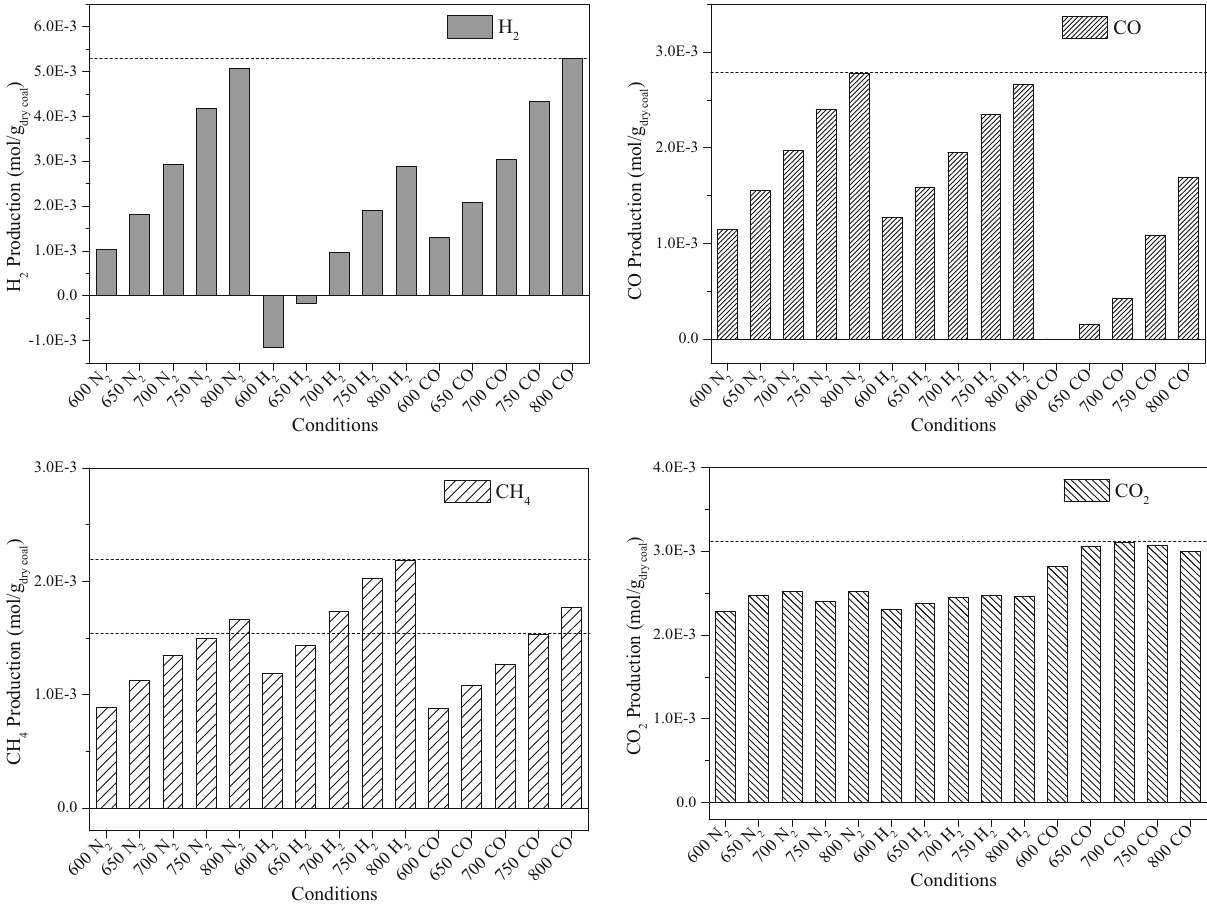
Fig. 6 The gas productions of coal pyrolysis under